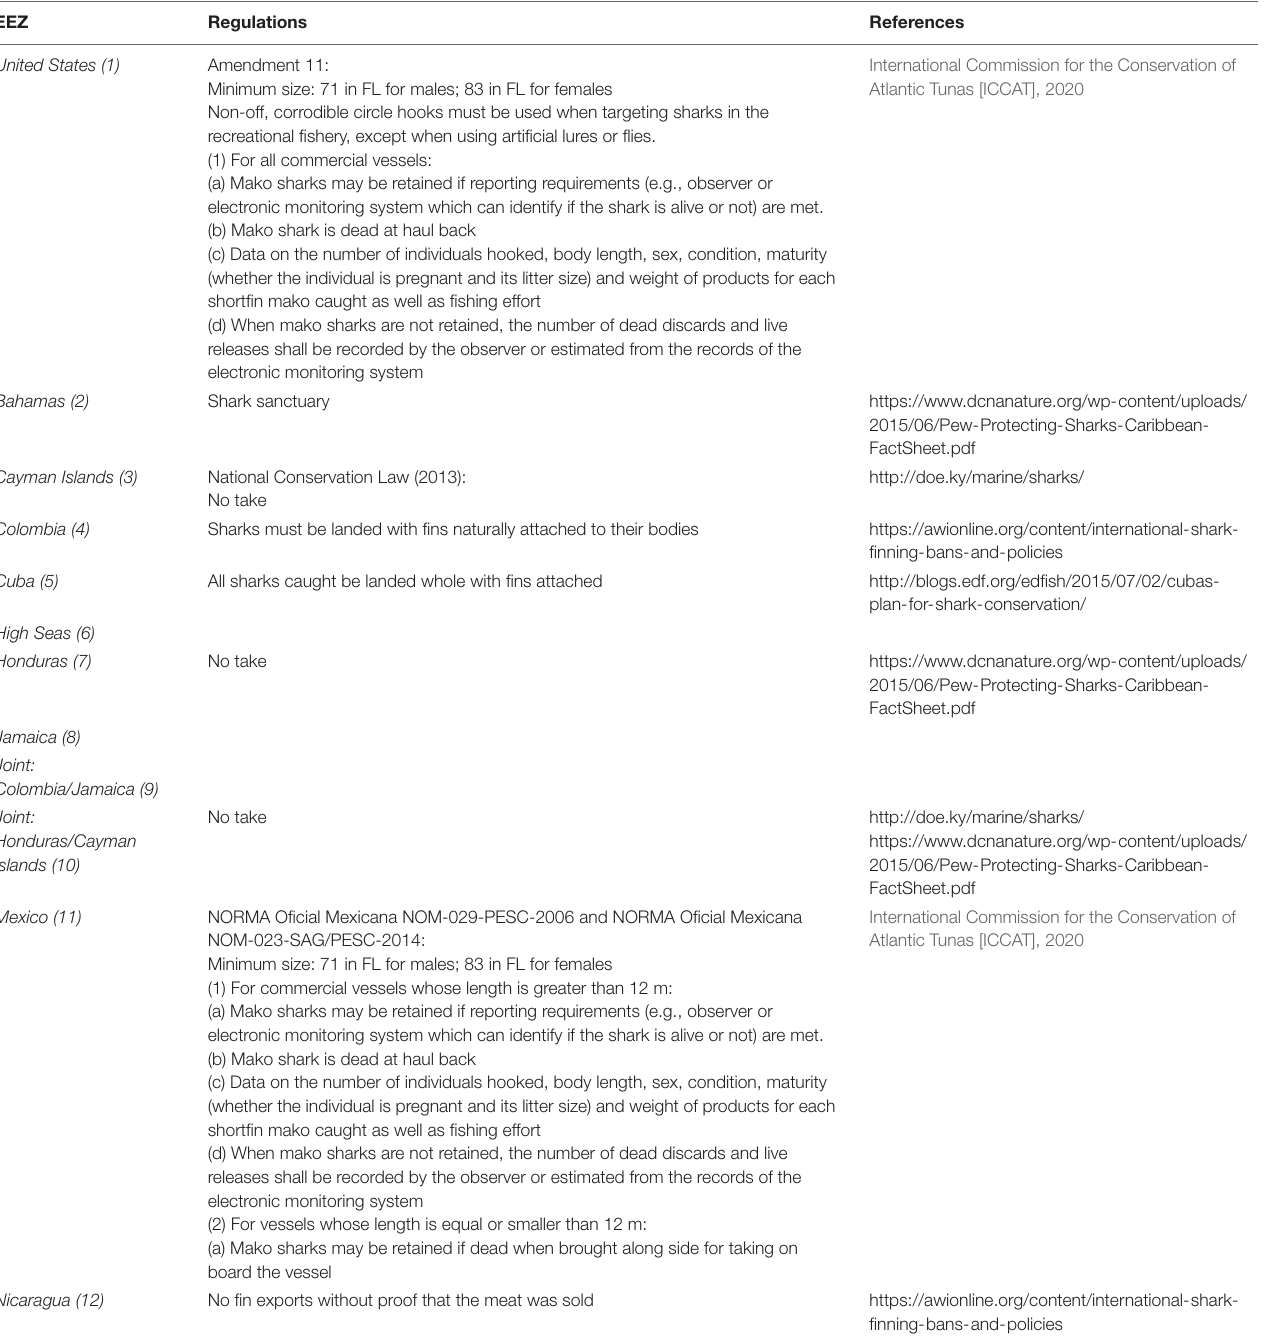
TABLE 2 | Regulations for each of the management jurisdictions that tagged mako sharks passed through during their excursions from the tagging region in the northwestern